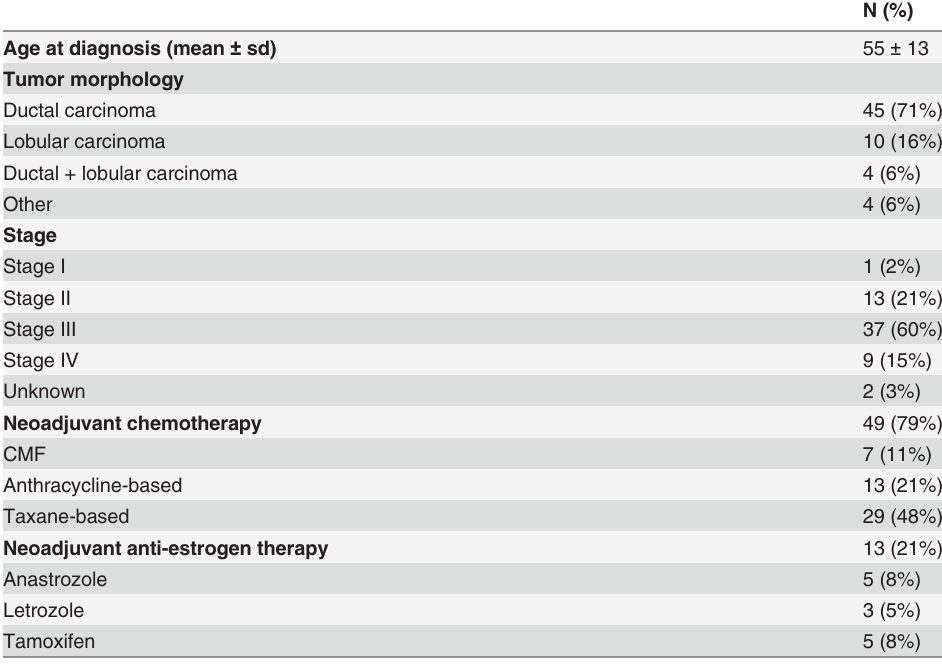
Table 2. Patient (N = 62) and tumor (N = 63)